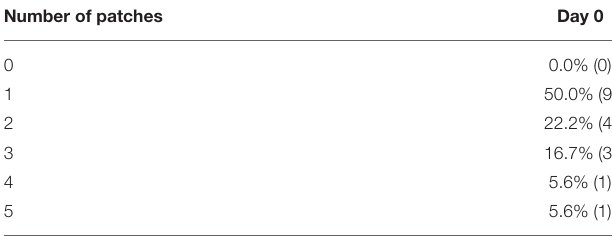
TABLE 1 | Number of irritated patches at the inclusion visit ( n =